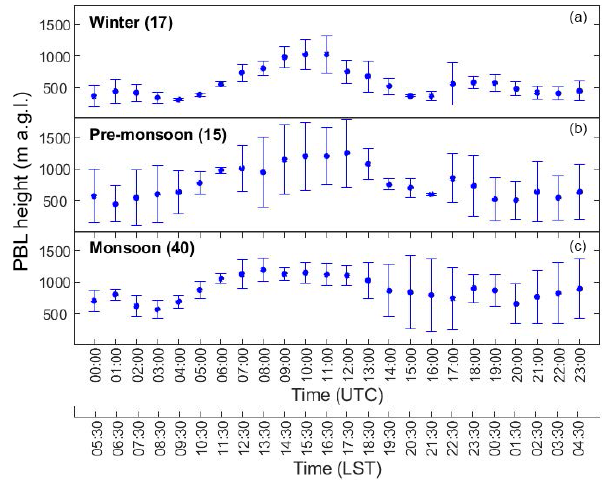
Figure 7. PBLH average diurnal cycle in Gwal Pahari according to FMI–Polly XT during winter (a) , pre-monsoon (b) and monsoon seasons (c) . Numbers indicate data